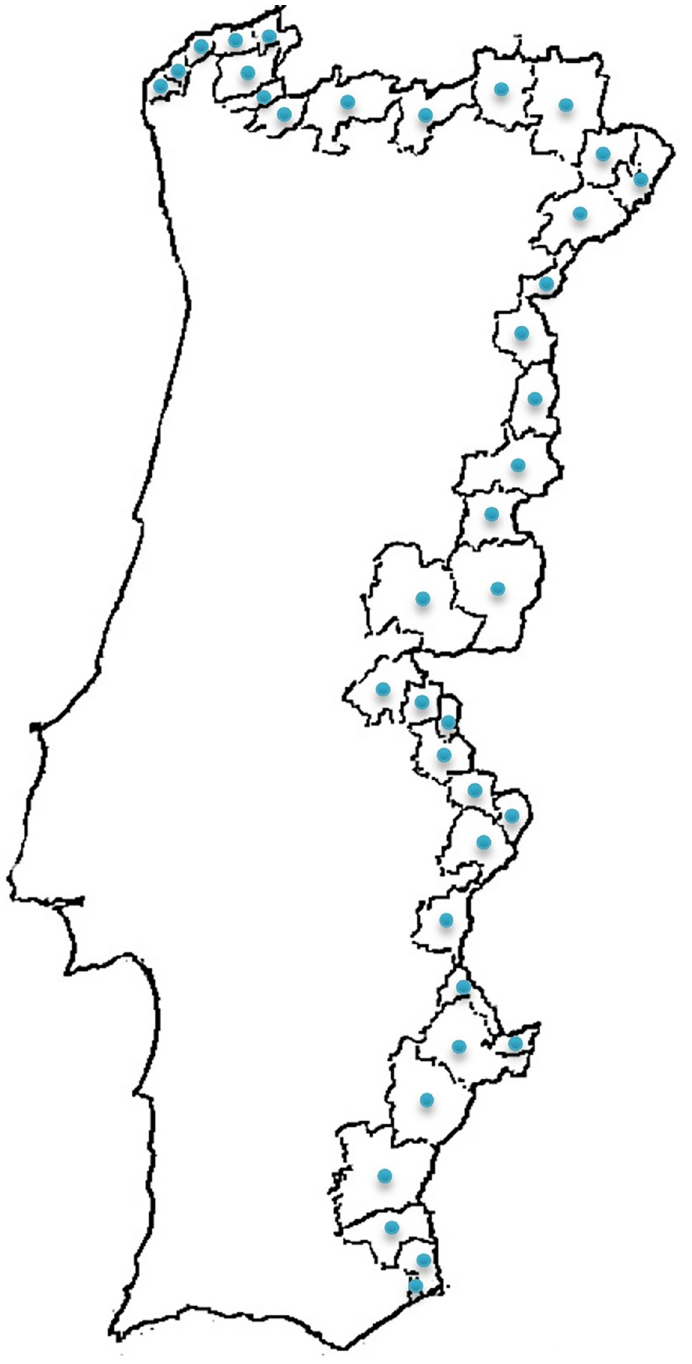
Fig 2. Research contexts (38